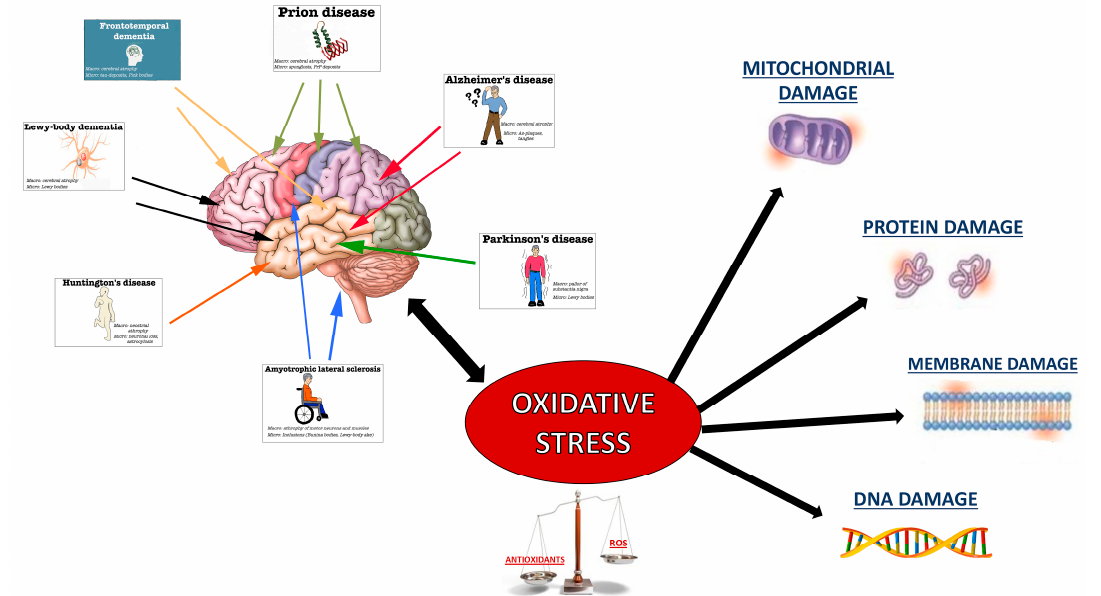
Figure 1. Interconnection between OS and NDs. The figure shows the main NDs (on the left; colored arrows represent the specific region for every NDs), while on the right, the damage emerging by OS—the common point for all